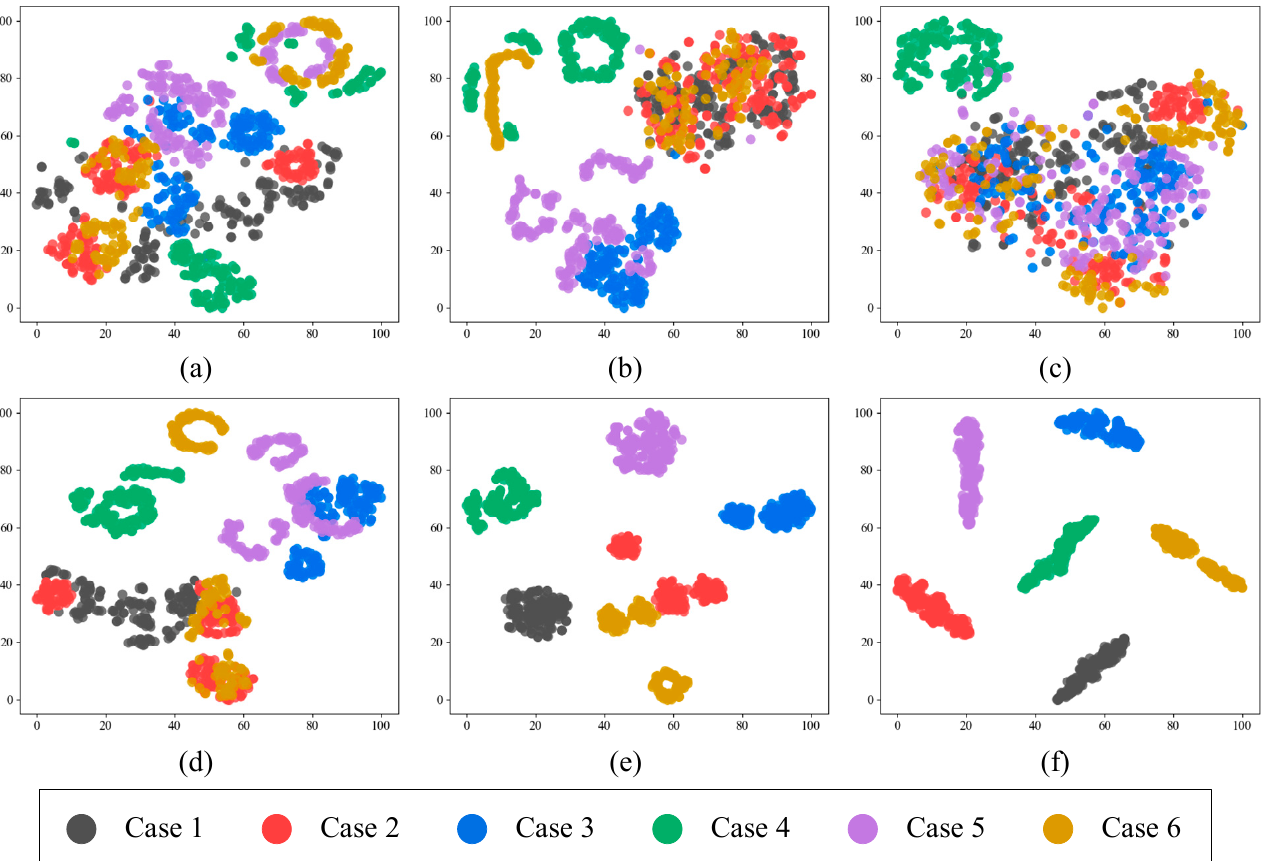
Figure 18. t-SNE visualization of network layer features: ( a ) Features extracted at the first scale; ( b ) Features extracted at the second scale; ( c ) Features extracted at the third scale; ( d ) Features obtained from feature fusion; ( e ) Features after CSAM correction; ( f ) The last layer features of the output